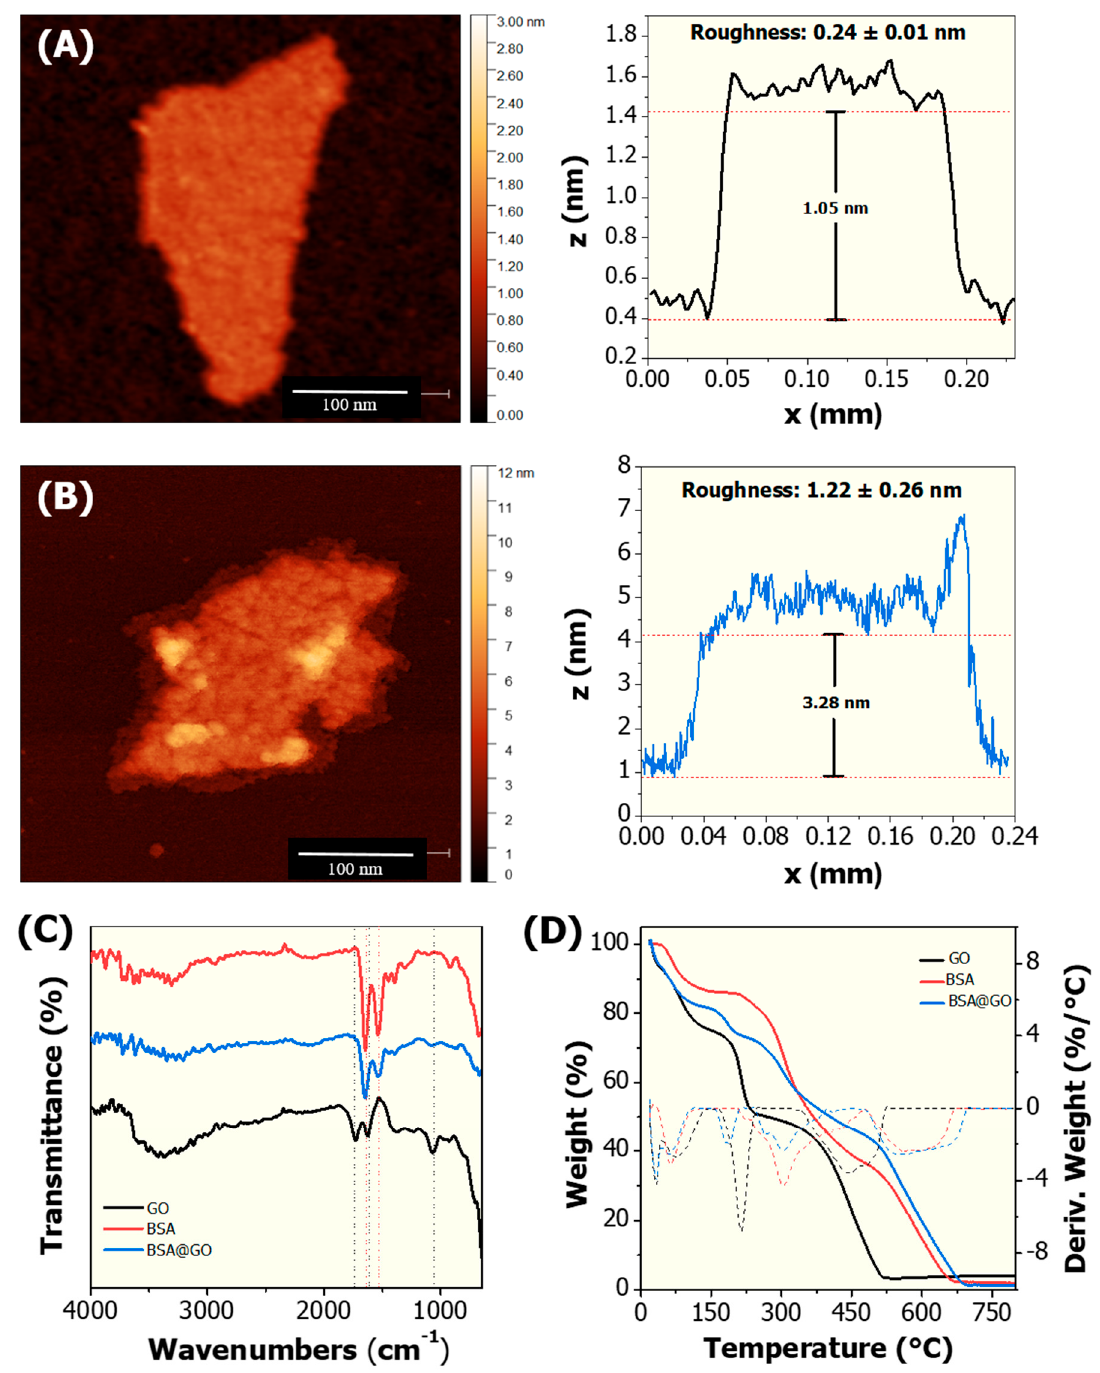
Figure 2. Characterisation of graphene oxide (GO) and the albumin corona coated graphene oxide (BSA@GO) materials: Atomic force microscopy (AFM) images and surface roughness analysis of ( A ) bare GO and ( B ) corona coated BSA@GO; ( C ) Attenuated total reflection Fourier infrared spectroscopy (ATR-FTIR); and ( D ) Thermogravimetric analysis (TGA) spectra of GO, BSA and BSA@GO .